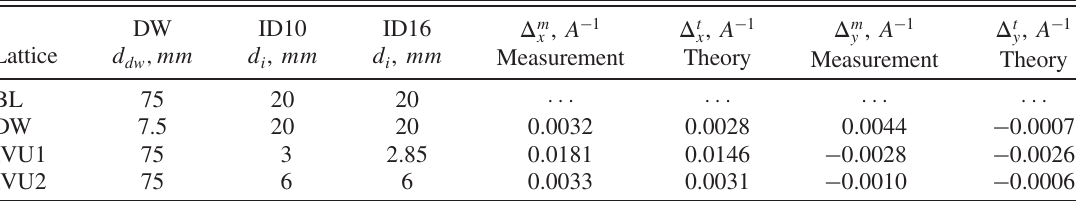
TABLE I. Comparison of the differences in tune slopes, measured Δ m x;y vs theoretical Δ t x;y for lattices with